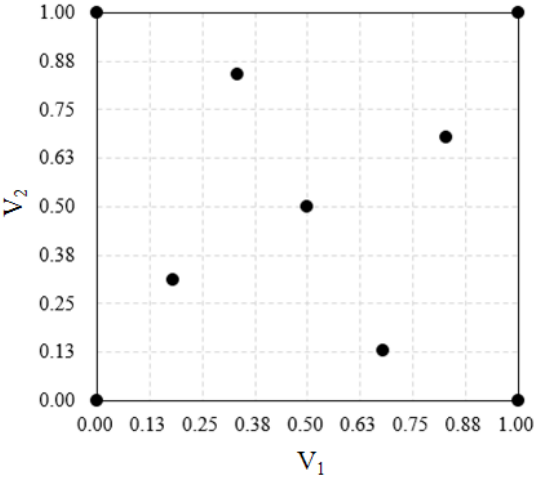
Figure 7. Example of the modified LHS.